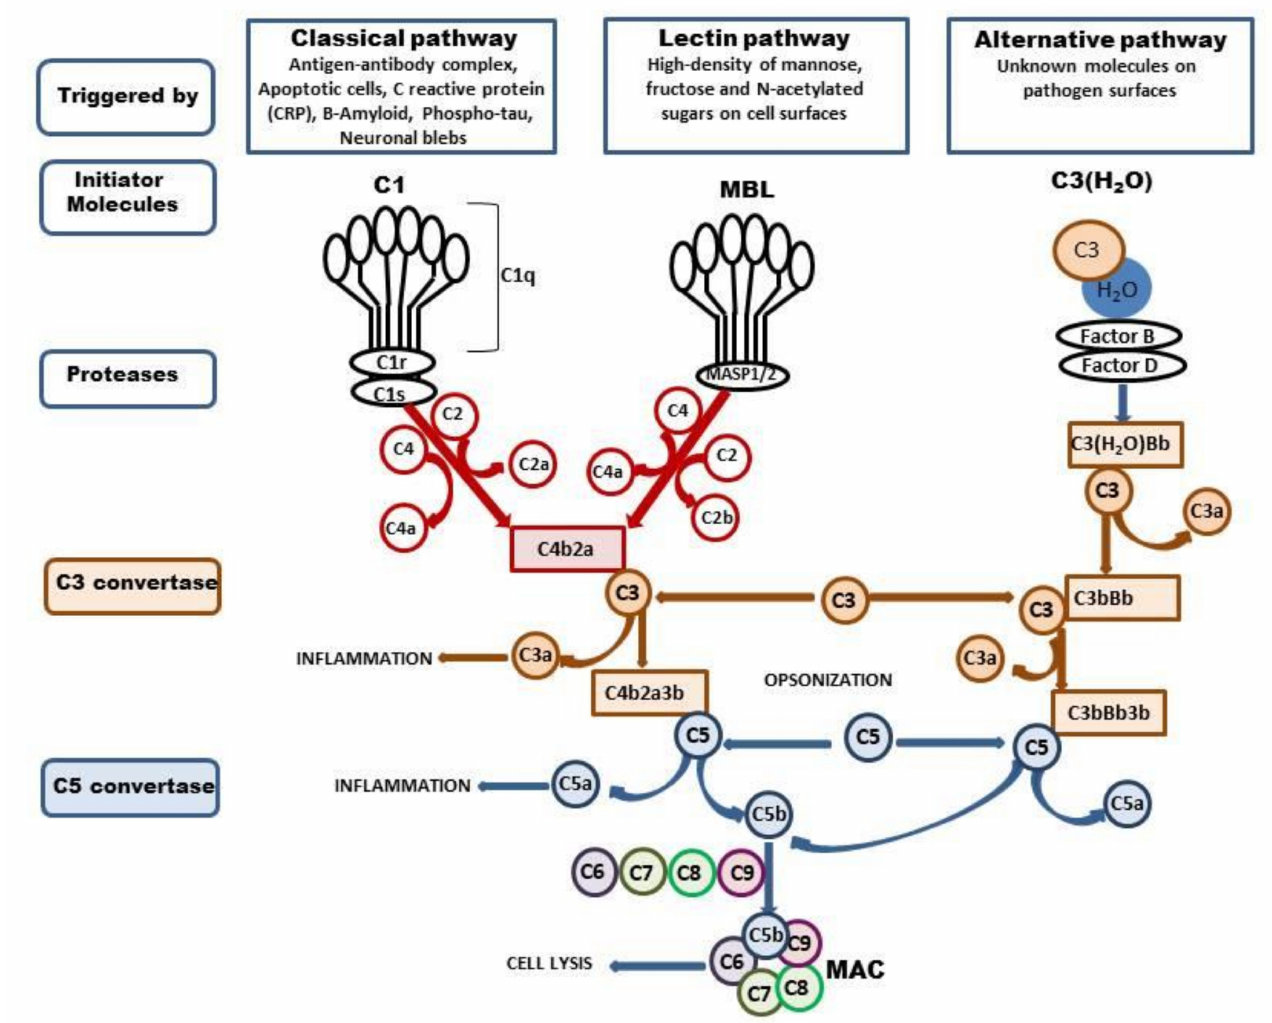
Figure 1. Activation of complement system. The complement system can be activated via three ways: classical, lectin, and alternative. The classical pathway is triggered by binding of the antibody-antigen complexes, apoptotic cells, CRP, B-Amyloid, phospho-tau, or neuronal blebs to C1. The C1 is composed with C1q, C1r, and C1s, and binding of Cq1 with enumerated components changes the C1 conformation and activates C1s protease. The active C1s cleaves the C4 to C4a and C4b and C2 to C2a and C2, and forms C3 convertase—C4b2a which splits C3 into two fragments, C3b, which can opsonize microbial pathogens, and C3a, which activates mast cells and macrophages and promotes inflammation. The lectin pathway is activated by the binding of mannose-binding lectin (MBL) to mannose residues on the pathogen surface. This in turn activates the MBL-associated serine proteases, MASP-1/2, which activate C4 and C2 and form C4b2a. The C3b can bind to C4b2b to form the C5 convertase (C4b2a3b). C5 is cleaved to form C5a, which promotes inflammation, and C5b, which binds to C6, C7, C8, and C9 and forms the membrane attack complex (MAC) which enables cell lysis. The alternative pathway is triggered by hydrolysis of C3 to C3-H 2 O; then, factors B and D generate the C3 convertase—C3(H 2 O)Bb, which cleaves other C3 molecules to C3a and C3b. This in turn forms C3bBb complex which continues cleavage of the C3 and enables formation of the C5 convertase—C3bBb3b, which cleaves C5 and leads to the formation of the